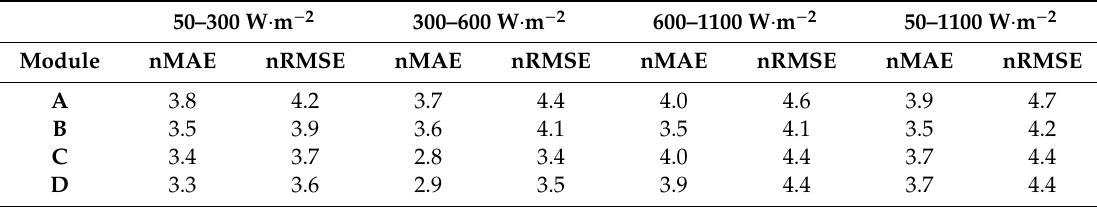
Table 5. Normalized nMAE and nRMSE on computed G per irradiance range, in %.